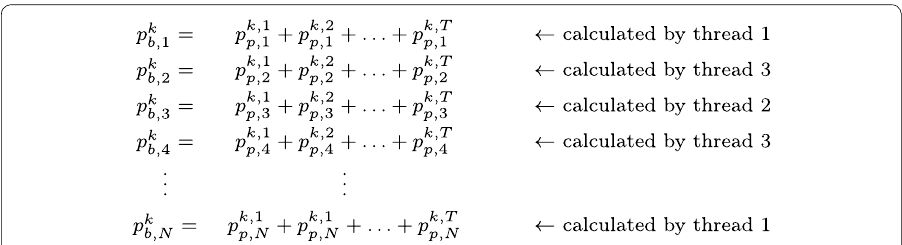
Fig. 4 This figure visualises the parallel summation of the thread projections in order to obtain the barycentre. In this example, three threads are randomly assigned to calculate the entire sum of all corresponding values p k , t p , n , t = 1, ... , T to obtain p k b , n . A racing condition is avoided since each thread operates on its own location in memory when saving p k b , n